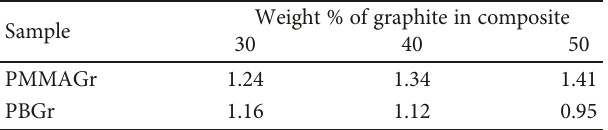
Table 1: Densities of PMMAGr and PBGr composite fi lms. Sample